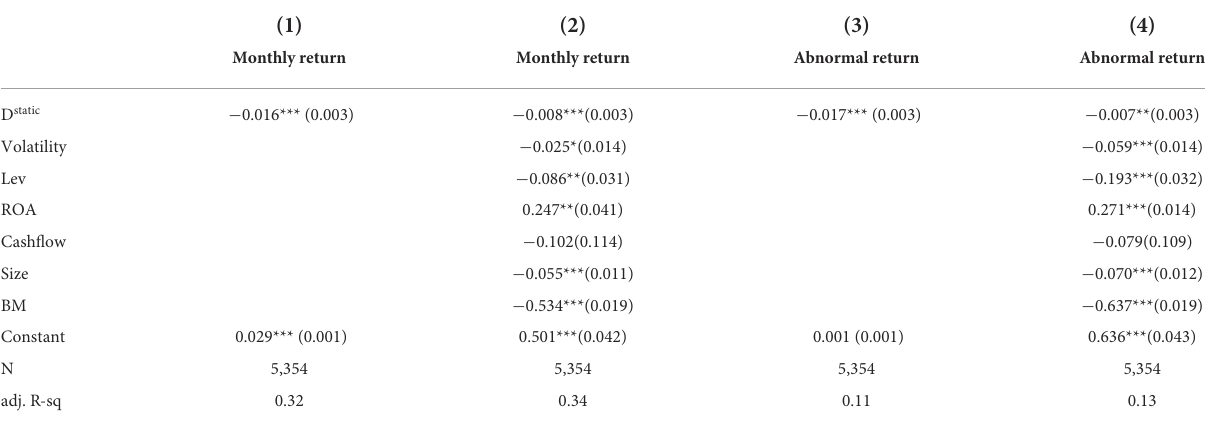
TABLE 1 The effect of CSR on stock return: main